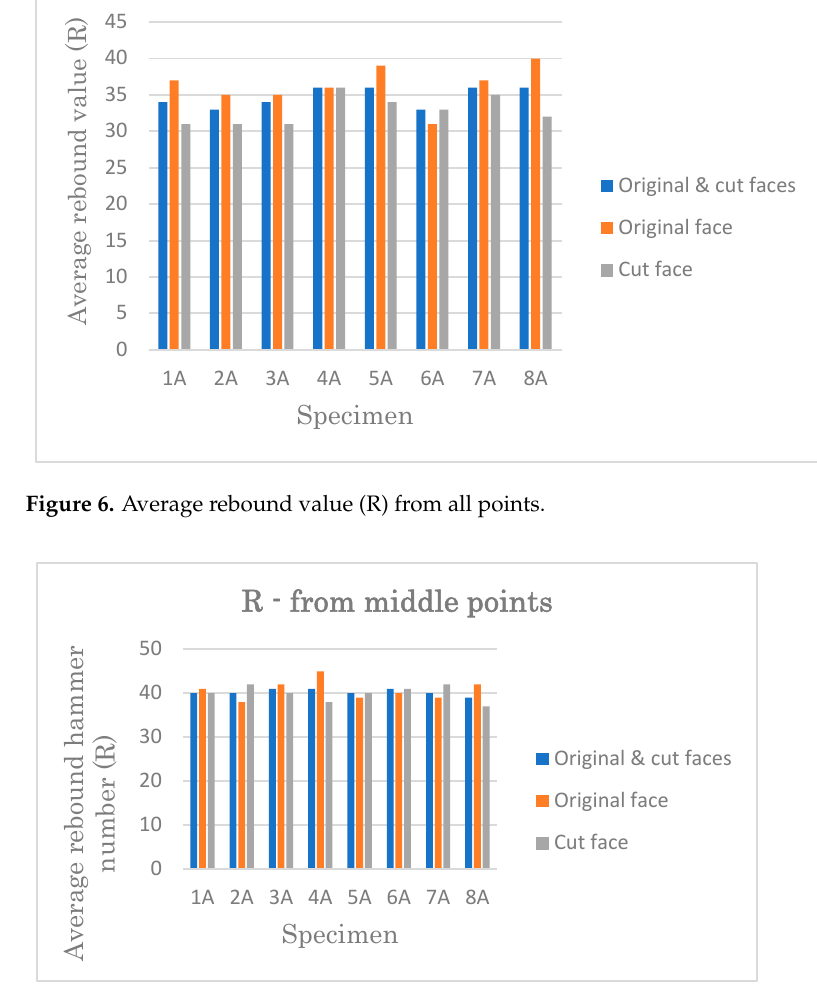
The average rebound value obtained from all locations varies with face types except